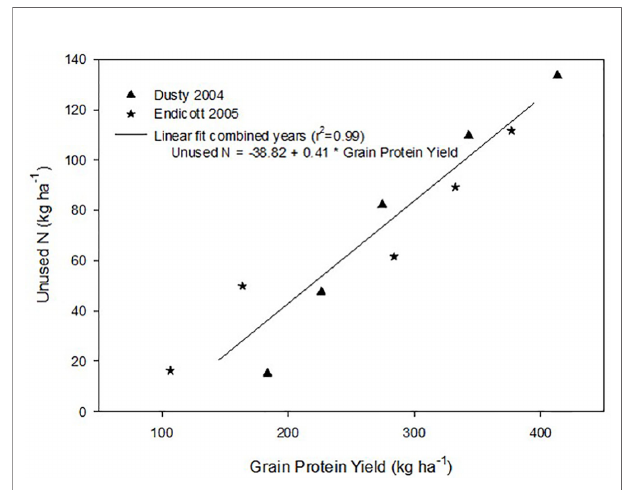
FIGURE 3 | Linear relationship between the amount of unused soil N left behind after harvest and the grain protein yield produced at each N supply over two years. Mean data averaged over all genotypes and replicates in both site years are linearly